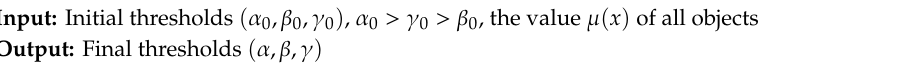
Algorithm 1: The improved threshold